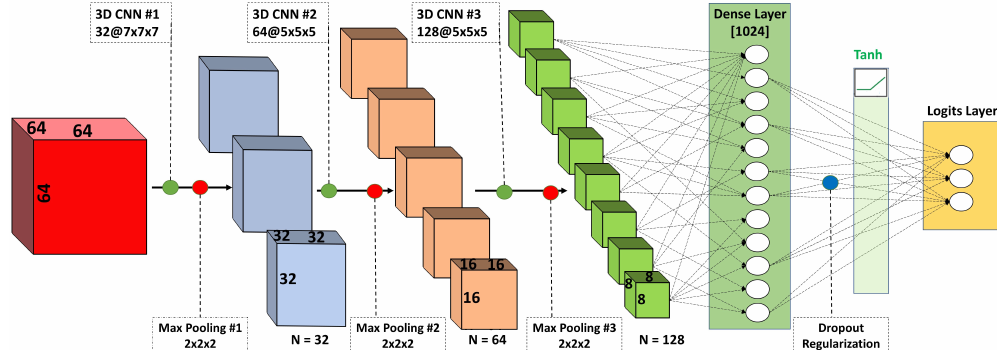
Figure 8. CNN architecture showing the layers of convolutional blocks of different size and the reduction of an input map to one of three output